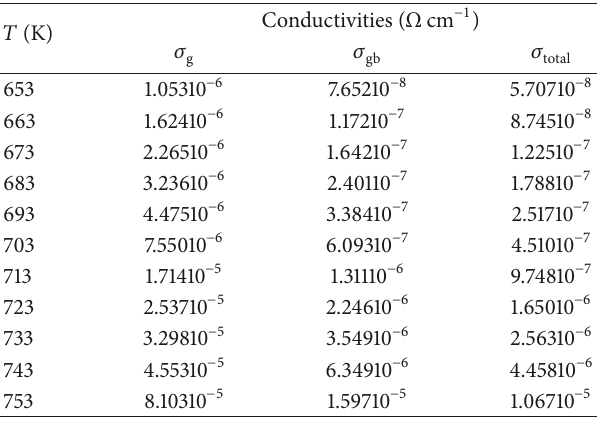
Figure 4: Arrhenius plot of conductivity of Na 2 K 2 Cu(MoO 4 ) 3 . Table 2: Ionic conductivities measurements value as a function of temperature in Na 2 K 2 Cu(MoO 4 ) 3 material.